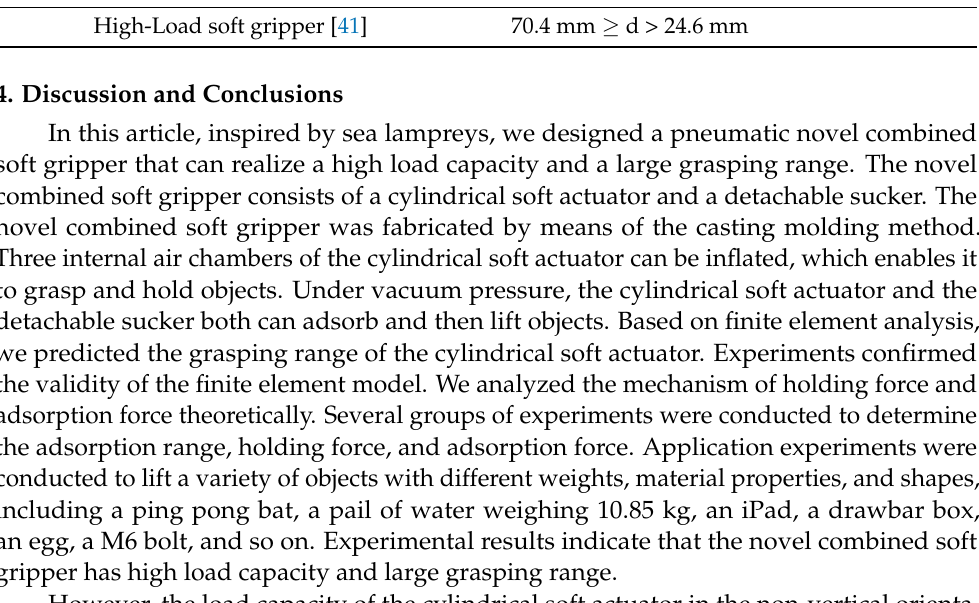
Grasping Range Grasping and